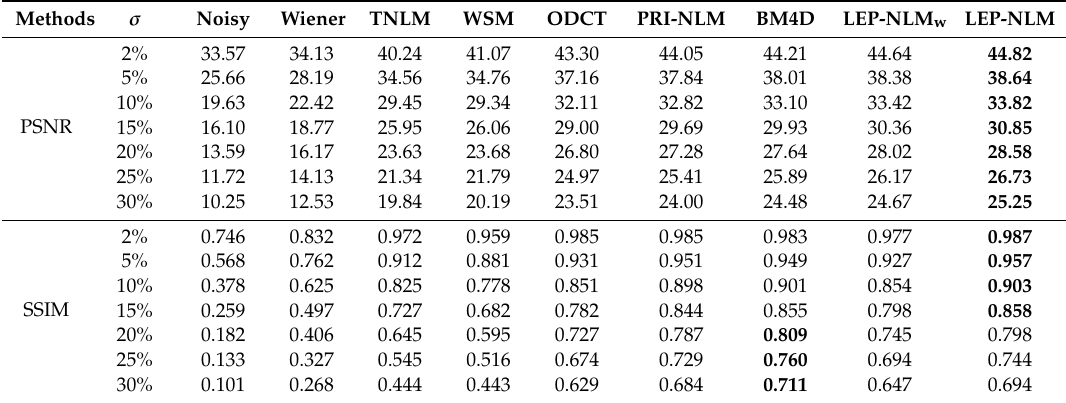
Table 2. PSNR / dB and SSIM comparison on the simulated T1-weighted images at di ff erent noise levels for the Wiener, TNLM, WSM, ODCT, PRI-NLM, BM4D, LEP-NLM, and LEP-NLM w methods. Methods